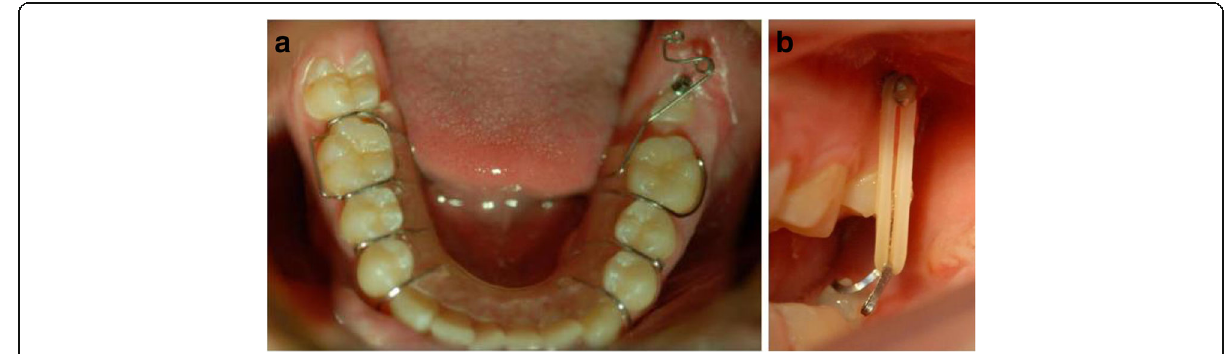
Fig. 10 Uprighting of a mesially tipped #37 with miniscrew implants, a modified removable appliance with an uprighting spring, and an elastomeric power chain. a A removable appliance with an incorporated uprighting spring (0.8 mm of SS wire) that provoked the distal uprighting of the #37. b The buccal mini screw was inserted in the maxilla in order to initiate buccal and vertical uprighting of the lower left